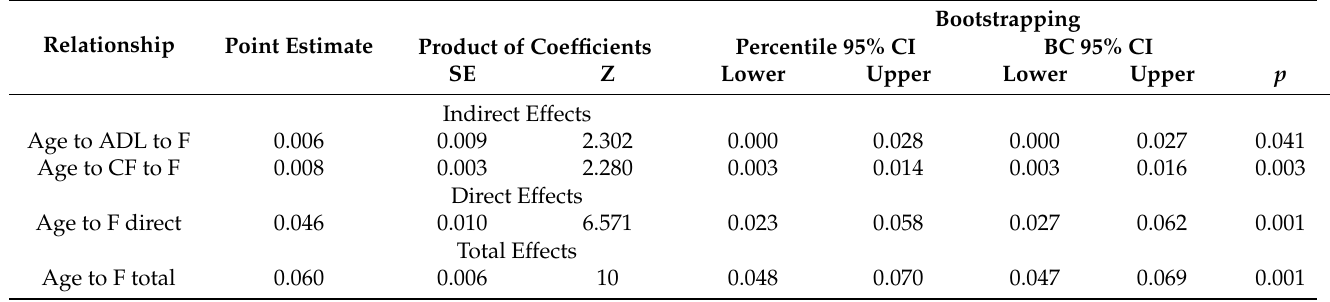
Table 3. Parallel multiple mediator model for effect of age on frailty.